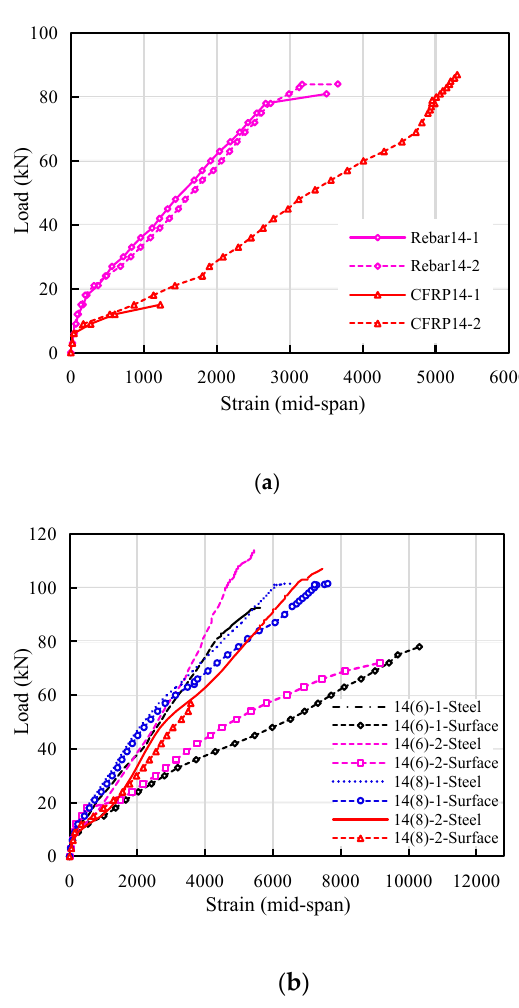
Figure 6. Comparison of strain in rebars. ( a ) strain comparison between CFRP and steel bar; ( b ) strain comparison between steel core and fiber.